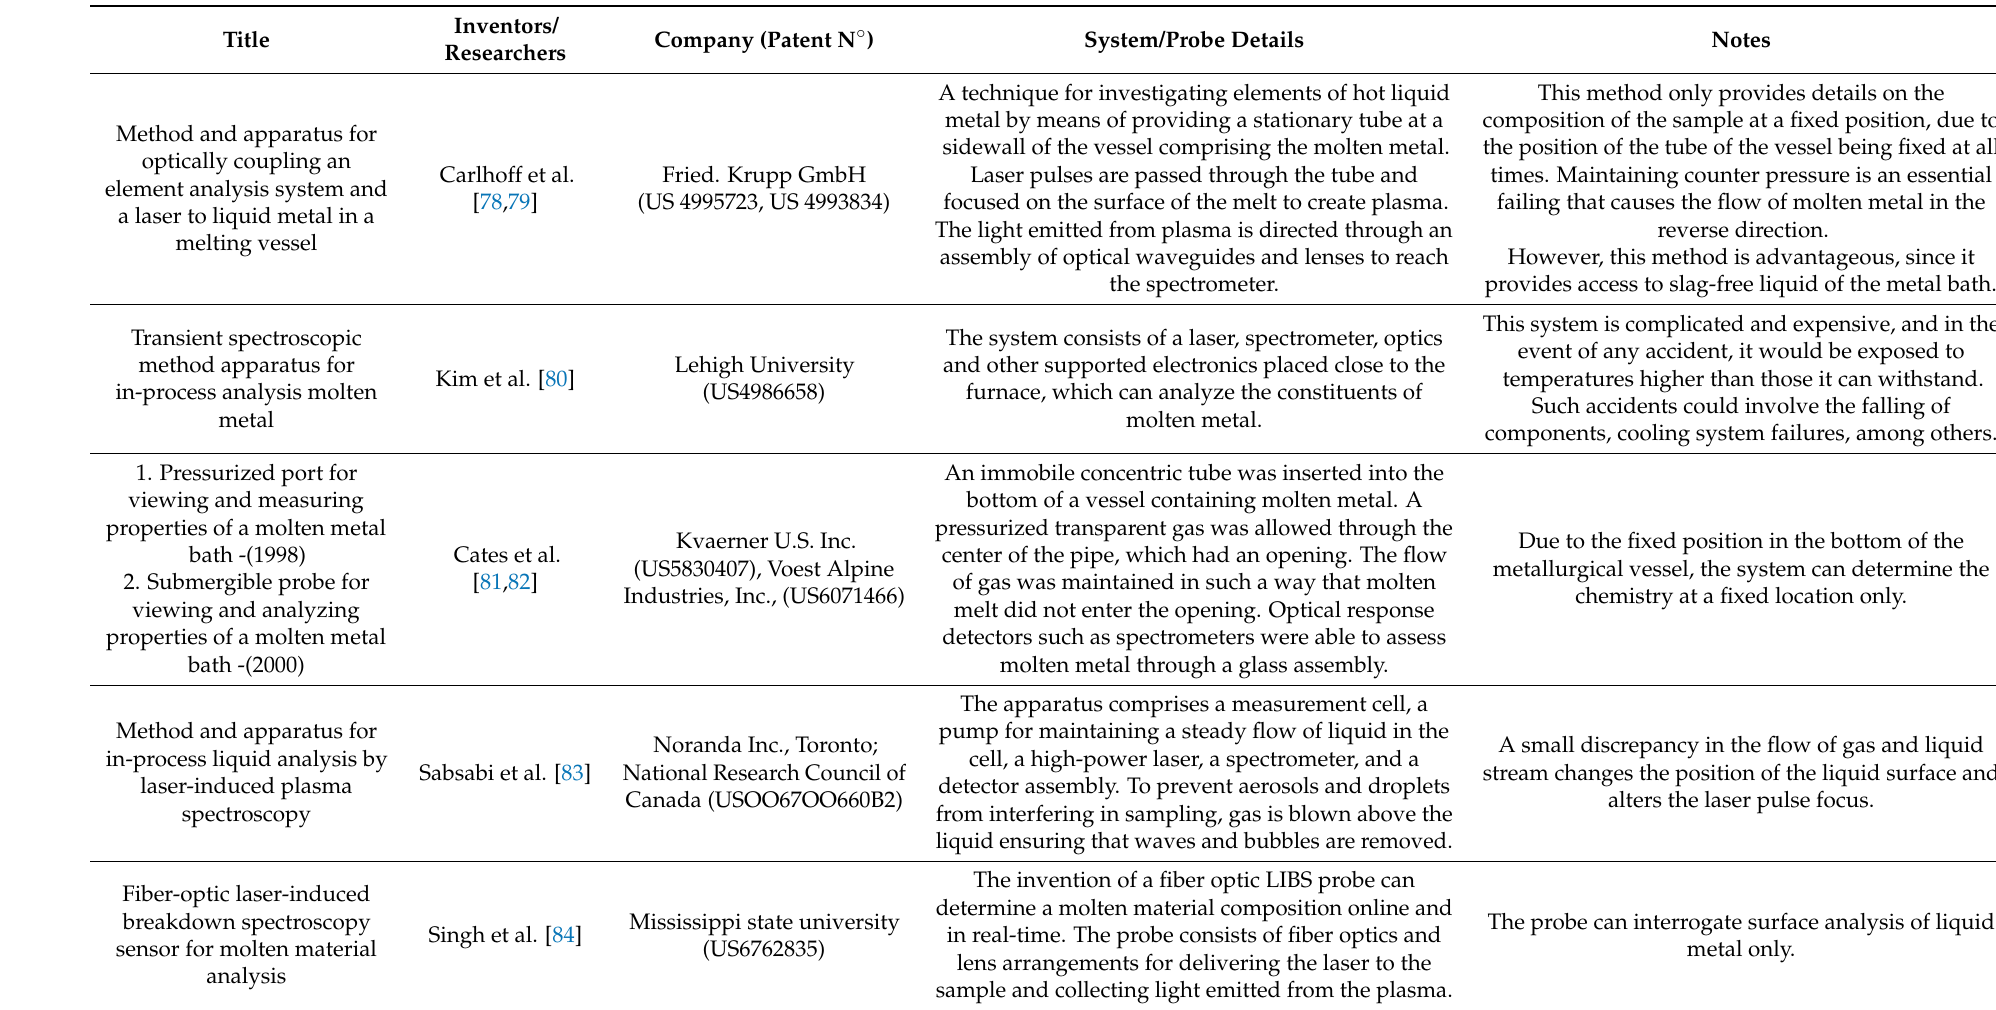
Table 2. Patents on LIBS and Molten material